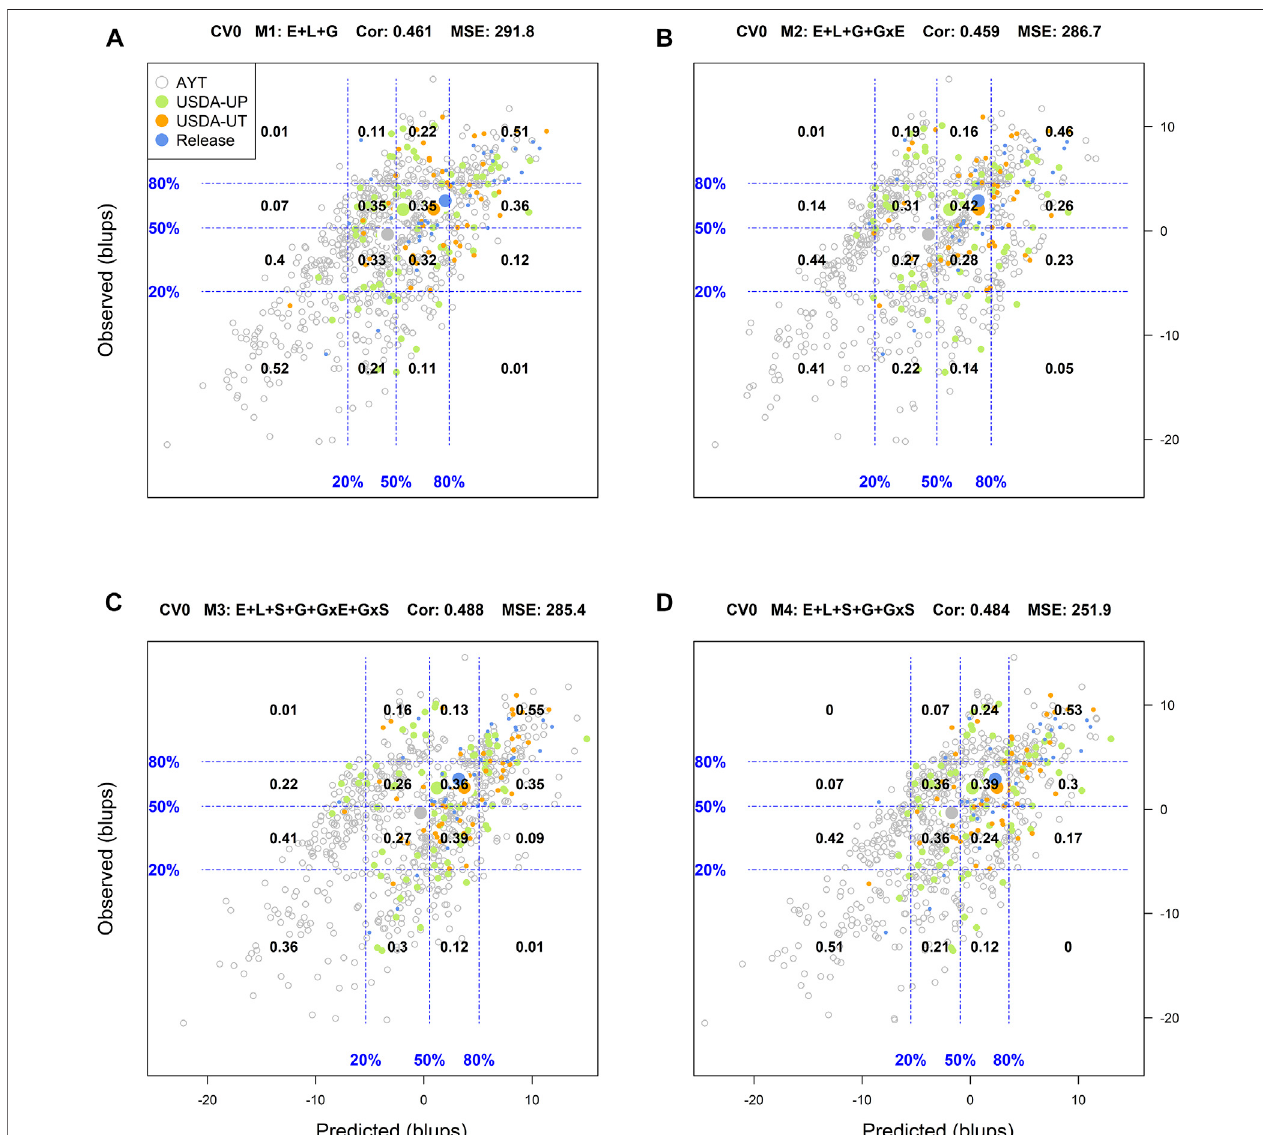
FIGURE 3 | Genotypic means (BLUP-centered on zero within environments) of observed versus predicted cross-validation predictions of four models (M1 – M4) under the cross-validation scheme CV0, which mimics the prediction scenario of predicting in novel environments (predicting tested genotypes in unobserved environments). Models and terms are described in detail in the Materials and Methods section ( Eqs 1 – 4 ). Horizontal and vertical dashed lines indicate the 20, 50, and 80%empiricalpercentilescorrespondingtotheobservedandpredicted values;thenumbersinsidethegridprovidetheconditionalproportionsobservedonthe y - axis for the different percentiles in the x -axis (e.g., out of the top 20% of the predicted values with M3 (panel C), 55% [top right] of these correspond to phenotypes that showed a performance among the 20% in fi elds).